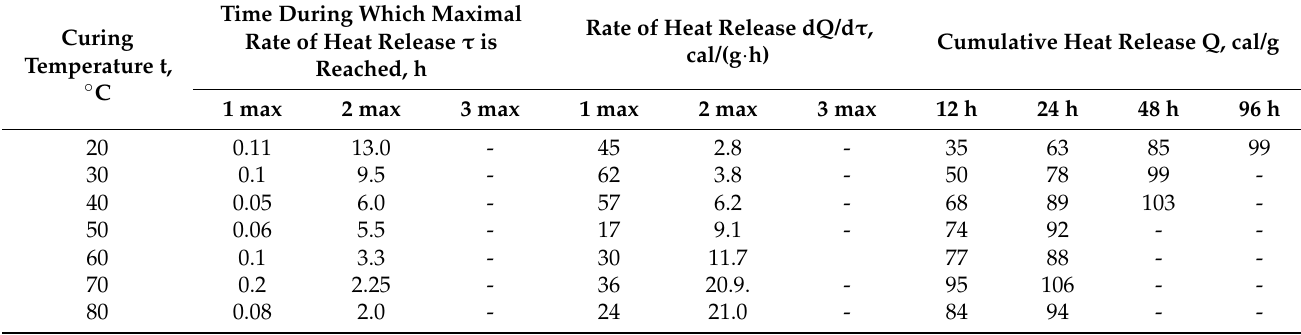
Table 3. The thermokinetic characteristics for the hydration process of the cement slag and Na 2 O · SiO 2 · 5H 2 O solution. Curing Temperature t, ◦ C